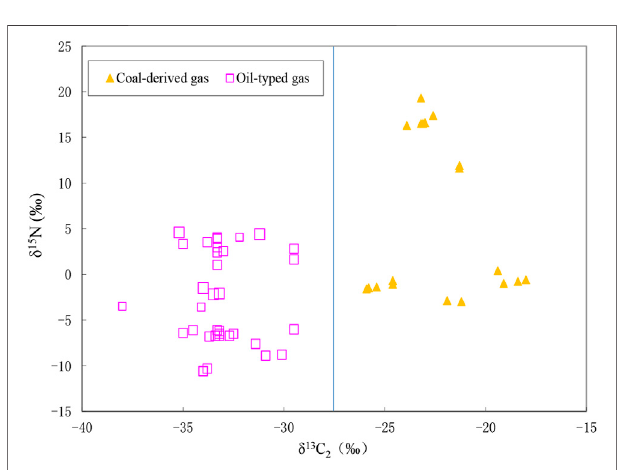
FIGURE 5 | Relationship between nitrogen isotope δ 15 N and ethane isotope δ 13 C 2 of coal-derived gas and oil-typed gas in China.